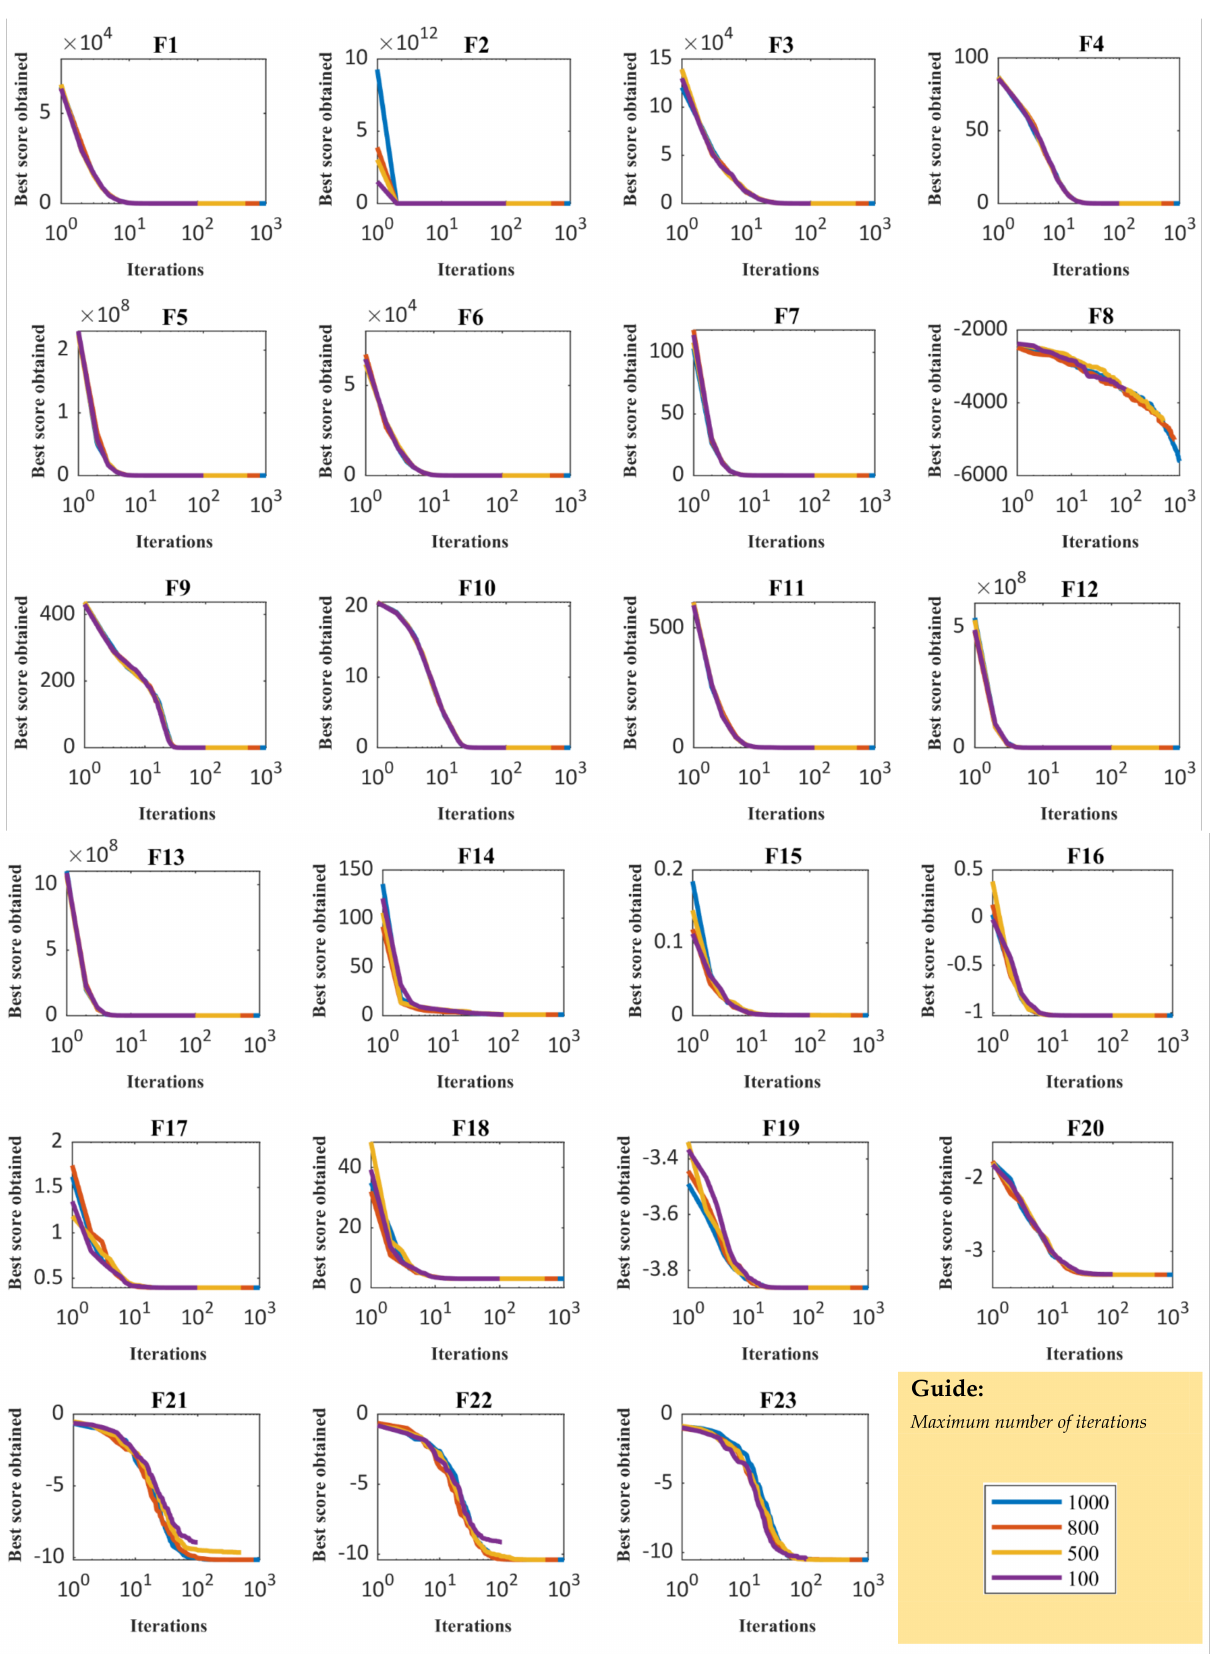
Figure 4. Sensitivity analysis of CMBO for maximum number of